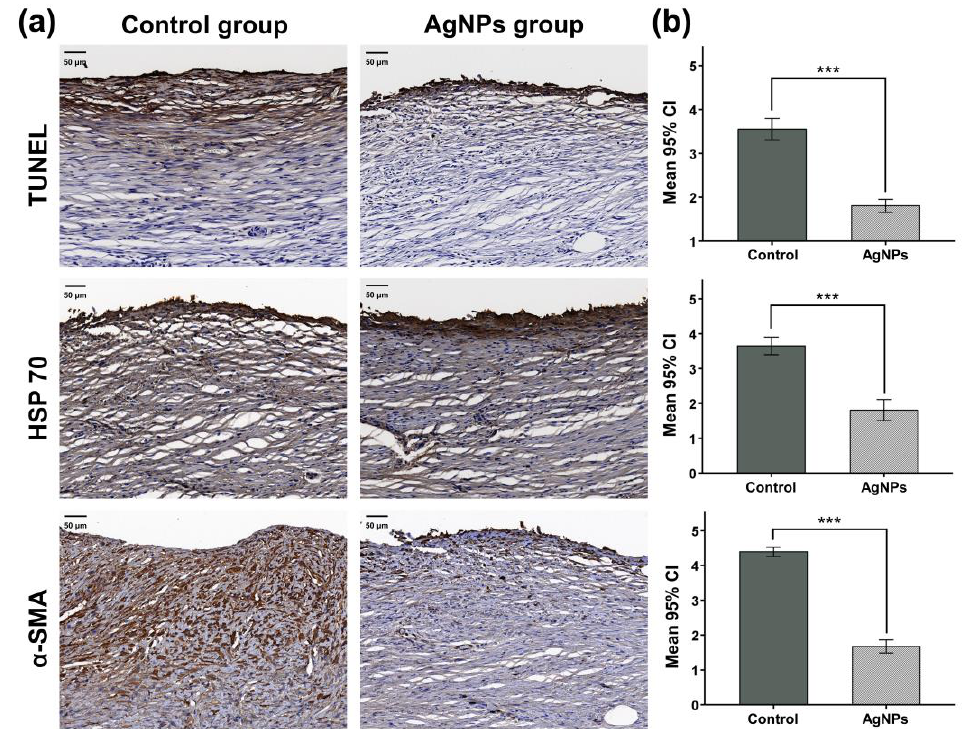
Figure 6. Representative microscopic IHC staining images and findings. ( a ) Representative images of terminal deoxynucleotidyl transferase-mediated dUTP nick and labeling (TUNEL)-, heat shock protein 70 (HSP 70)- , and α - smooth muscle actin (α -SMA)-stained sections are shown. ( b ) The mean degrees of positive staining were significantly higher in the control group than in the AgNPs group. CI, confidence interval; *** p < 0.001.